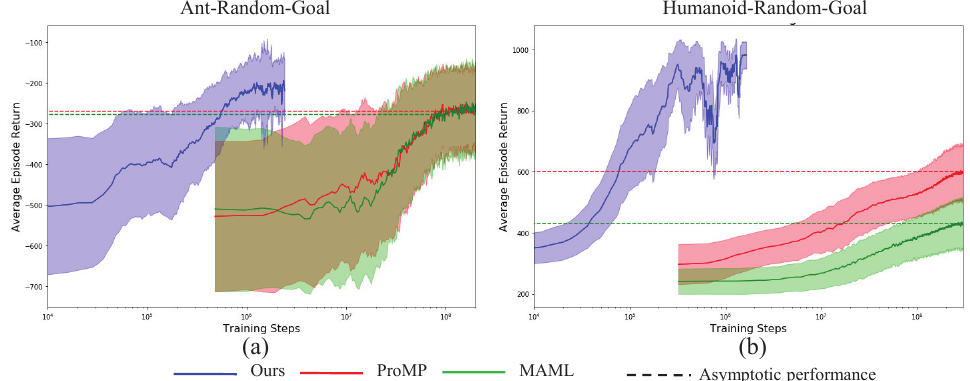
Figure 4. Performance comparisons for Ant ( a ) and Humanoids ( b ) with different goal location transfer learning tasks.